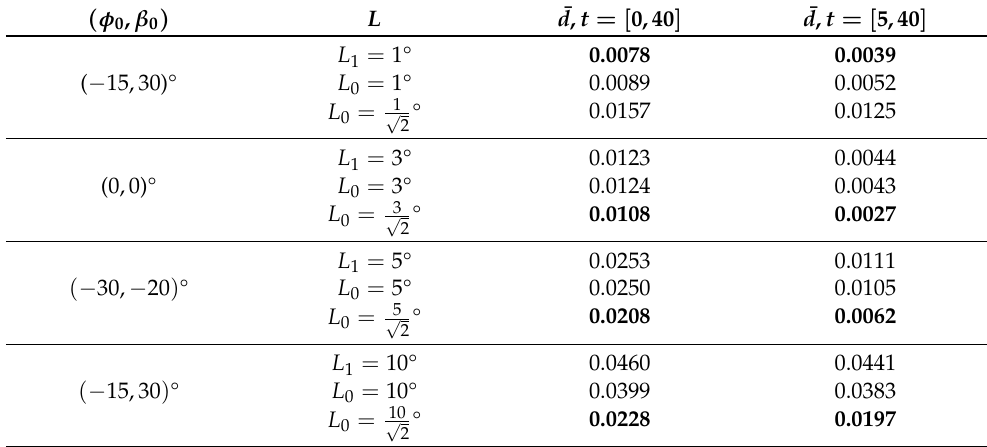
Table 2. Parameters used in the